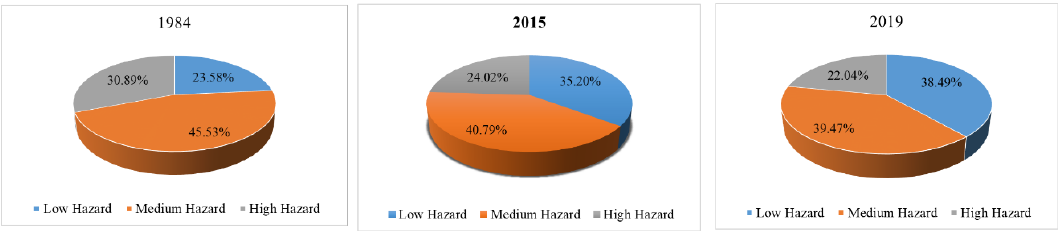
Figure 12. The exposed percentage areas for the flood hazard levels over time from 1984 to 2019.